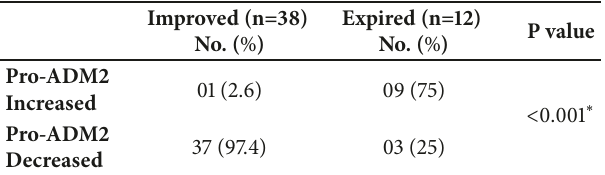
Table 3: Comparison of change in levels of Pro-ADM1 and Pro- ADM2 and outcomes in the sepsis